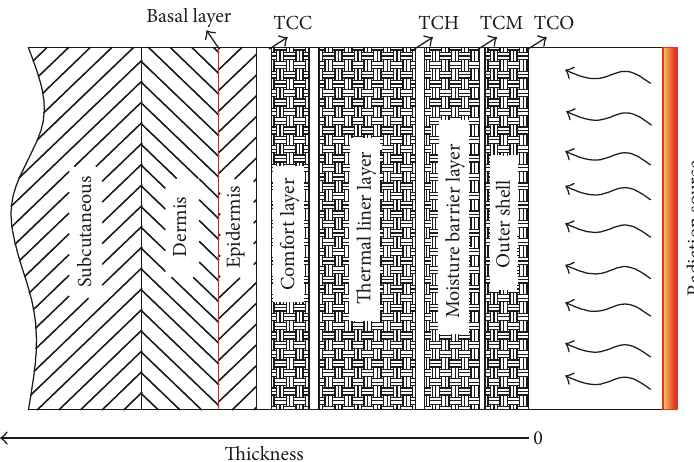
Figure 3: Sketch of heat and moisture transfer in FPC materials and heat transport in human